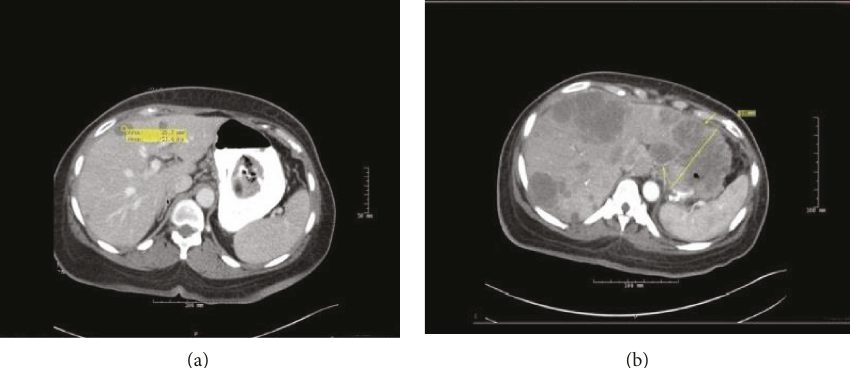
Figure 1: (a) CT imaging of the abdomen and pelvis with IV and oral contrast. Initial presentation with gastric mass and liver metastasis. (b) Repeatedimagingonsubsequentadmission6weekslaterwithanincreaseinthesizeofgastricmassandliverinvasionandworseningmetastasis.